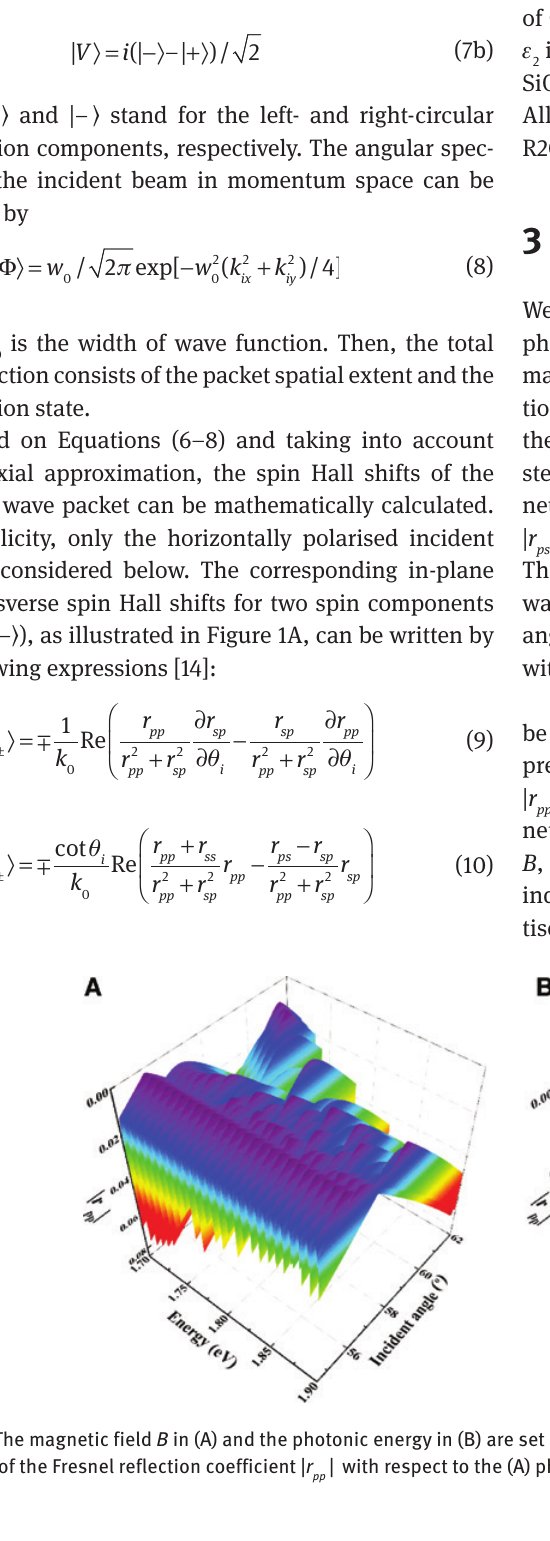
| with respect to the (A) photonic energy and (B) magnetic field B at different incident pp